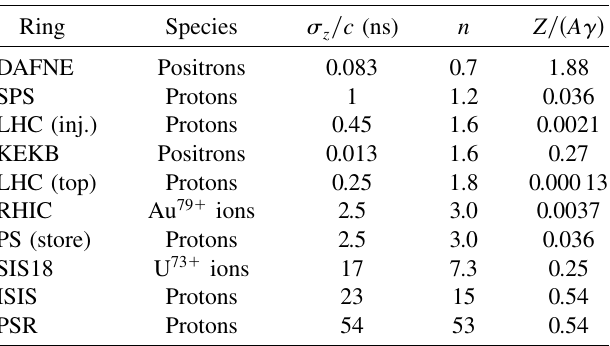
TABLE II. Selected storage rings with electron-cloud con- cerns, the type of stored particles, typical rms bunch length, parameter n defined in the text, and rigidity